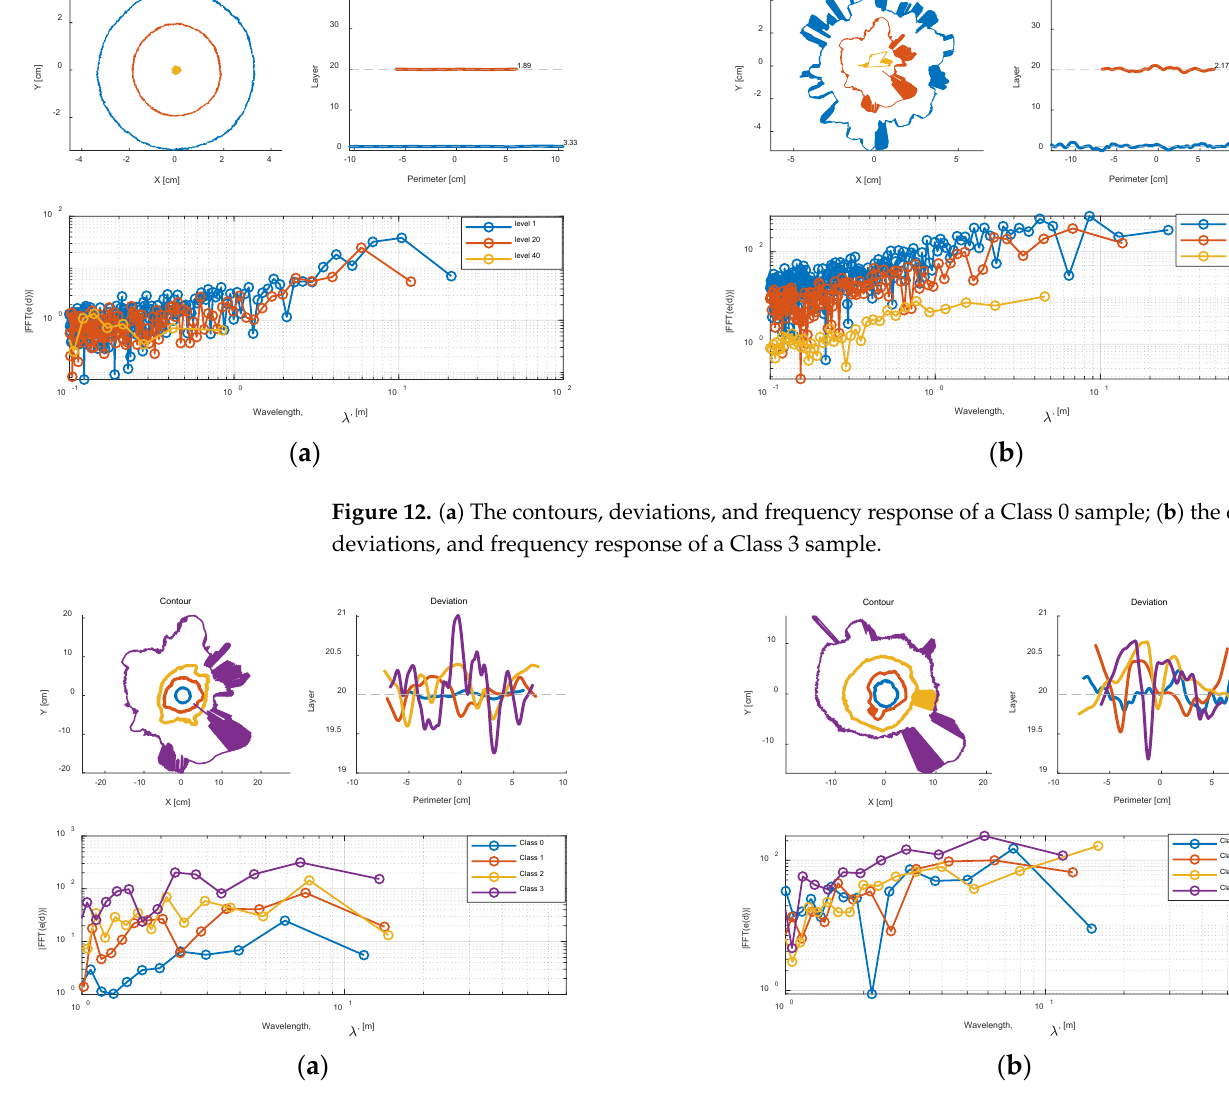
( b ) Figure 14. ( a ) Comparing the frequency response of the Class 0 – 3 instant trim samples; ( b ) comparing the frequency response of the Class 0 – 3 instant whole samples. 4.5. Classification of the Surface Roughness Since the Q value of each layer can be calculated, the Q values of 40 layers for each milk powder sample were used to build the classifier to categorize the surface roughness of milk powders. Additionally, since each moisture level has 6 milk power cones (three instant trim cones and three instant whole cones), this study has 24 milk powder cones in total. Figure 15 presents the results of the nonlinear SVM classifier. The blue parts in the confusion chart represent the true positive and true negative predictions, and the false negatives and false positives from the predictions are shown as reddish cells. Table 2 lists the specificities and sensitivities of the developed SVM model. For the performance of the model developed in [53], only one milk powder sample was wrongly predicted, while from these results, all the smooth milk powder samples (Class 0) and the extremely rough- surface milk powder samples (Class 3) were predicted correctly. However, one Class 1 sample was incorrectly classified as a Class 0 sample, and two Class 2 milk powder